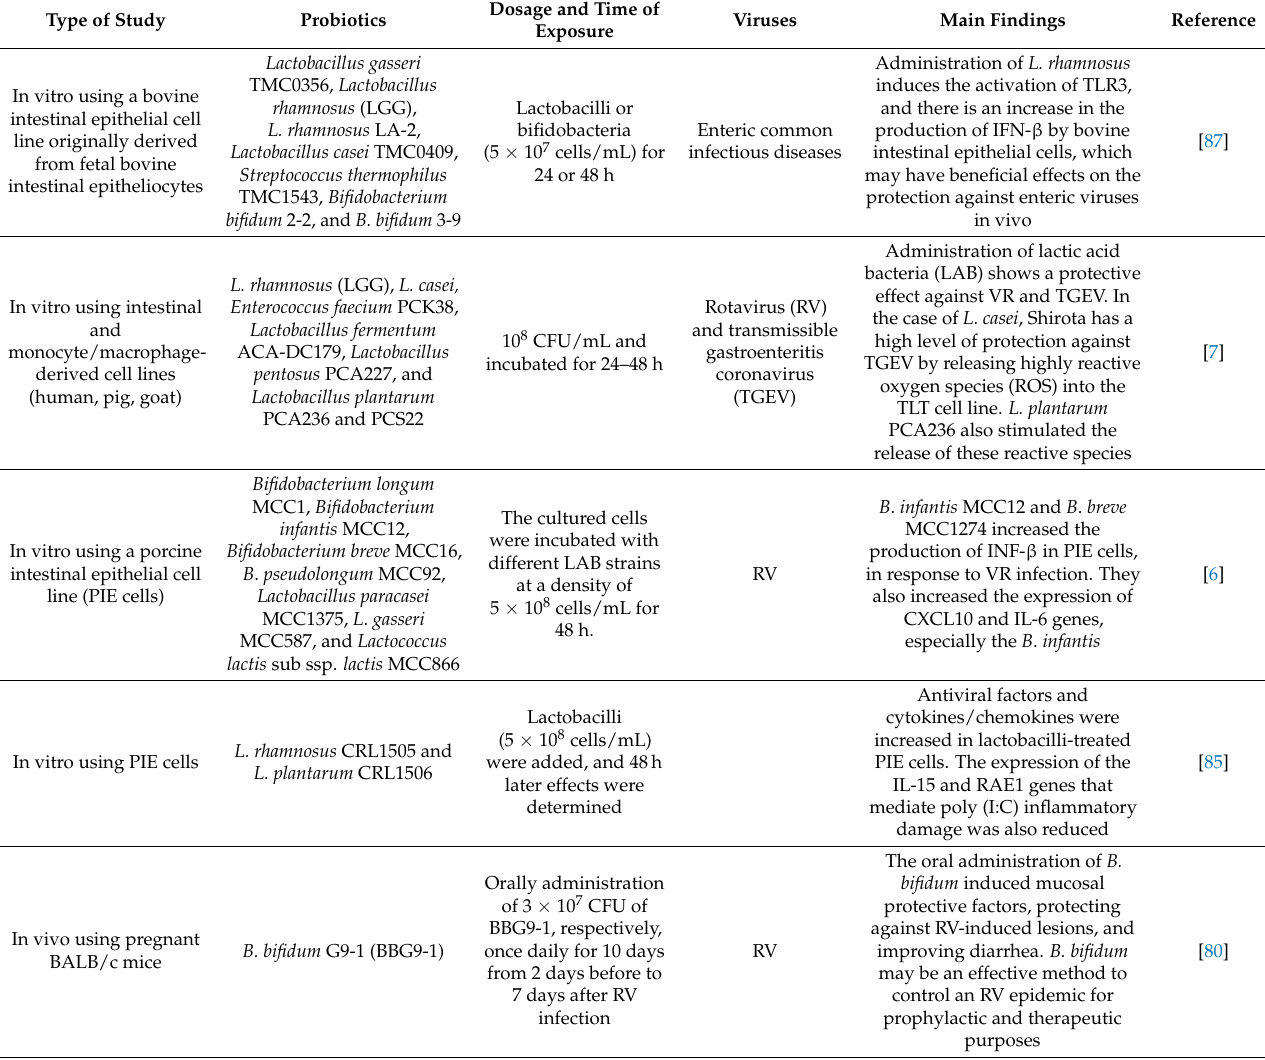
Table 2. Effects of probiotics against digestive